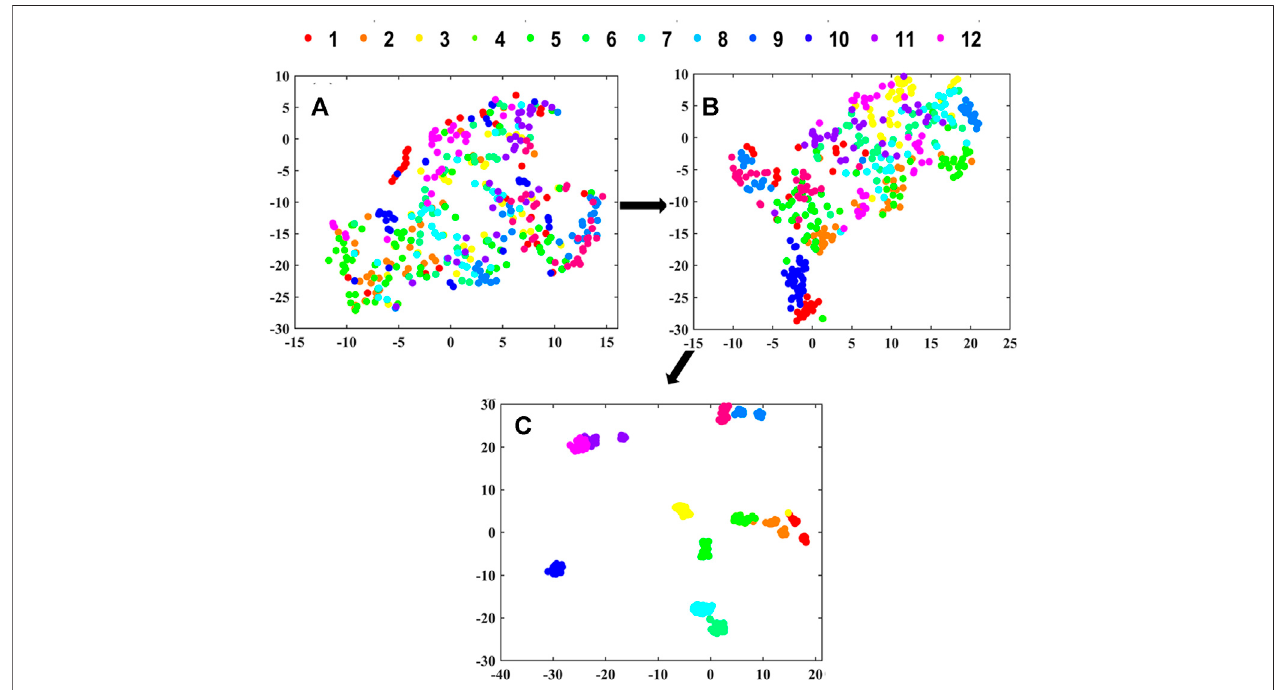
FIGURE 9 | The clustering visualization in layers of (A) Conv. 1Block1, (B) Conv. 1Block2 and (C) Dense 12 in 2D-CNN for underground parts by